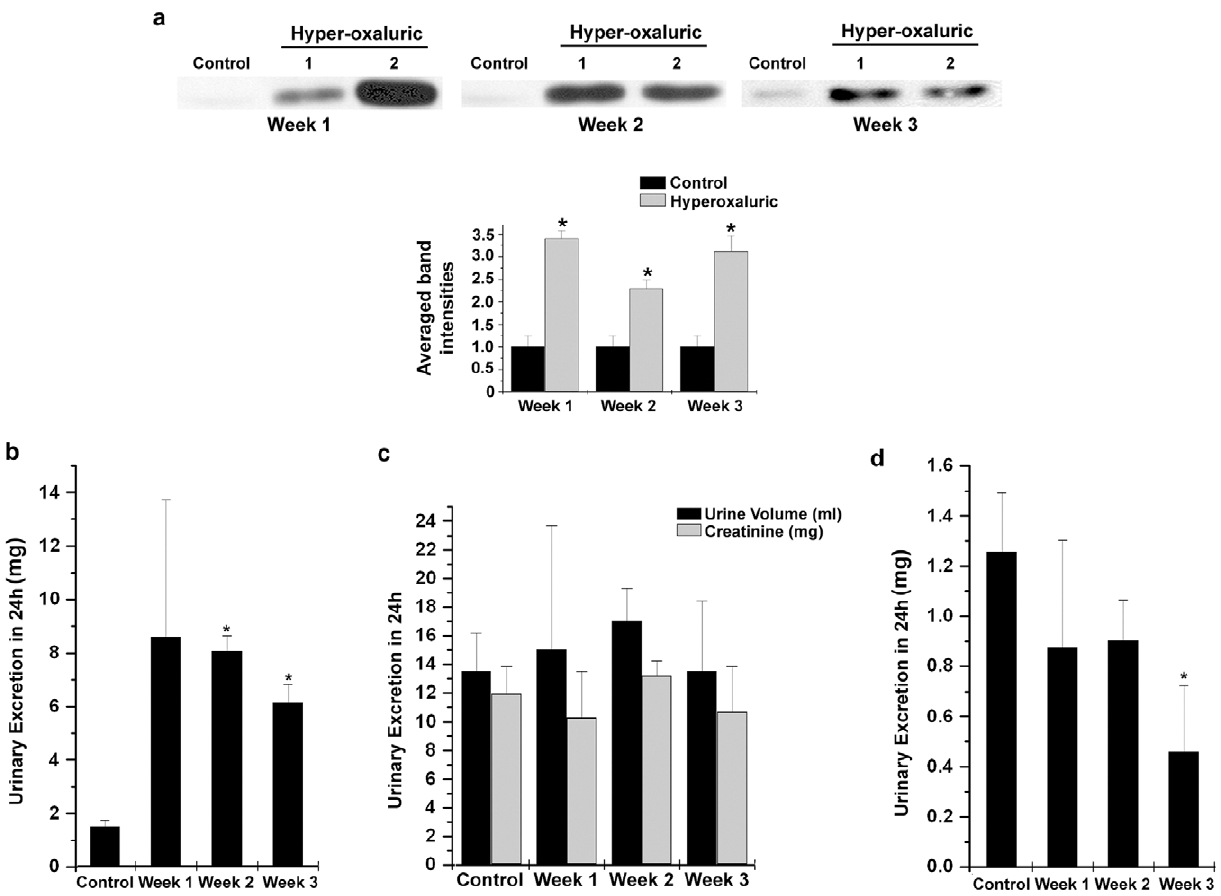
Figure 5. Hyper-oxaluria results in increased shedding of KIM-1 ectodomain in rat urine. ( a ) Western blot to detect KIM-1 protein shed in the urine of two individual hyper-oxaluric rats. Representative gel images from three individual western blots are shown ( Upper Panel ). Quantitative representation of the relative amounts of KIM-1 protein in urine, averaged across the treatment groups, is shown in the lower panel . Each data point represents mean + / 2 S.D. of three blots (* indicates p , 0.05 compared to control, n=3). ( b ) Urine Volume (ml) and Creatinine excretion (mg) values ( c ) Oxalate (mg) and ( d ) Calcium (mg) over a period of 24 hours. Each data point represents mean + / 2 S.D. of individual animals in each group (* indicates p , 0.05 compared to control).